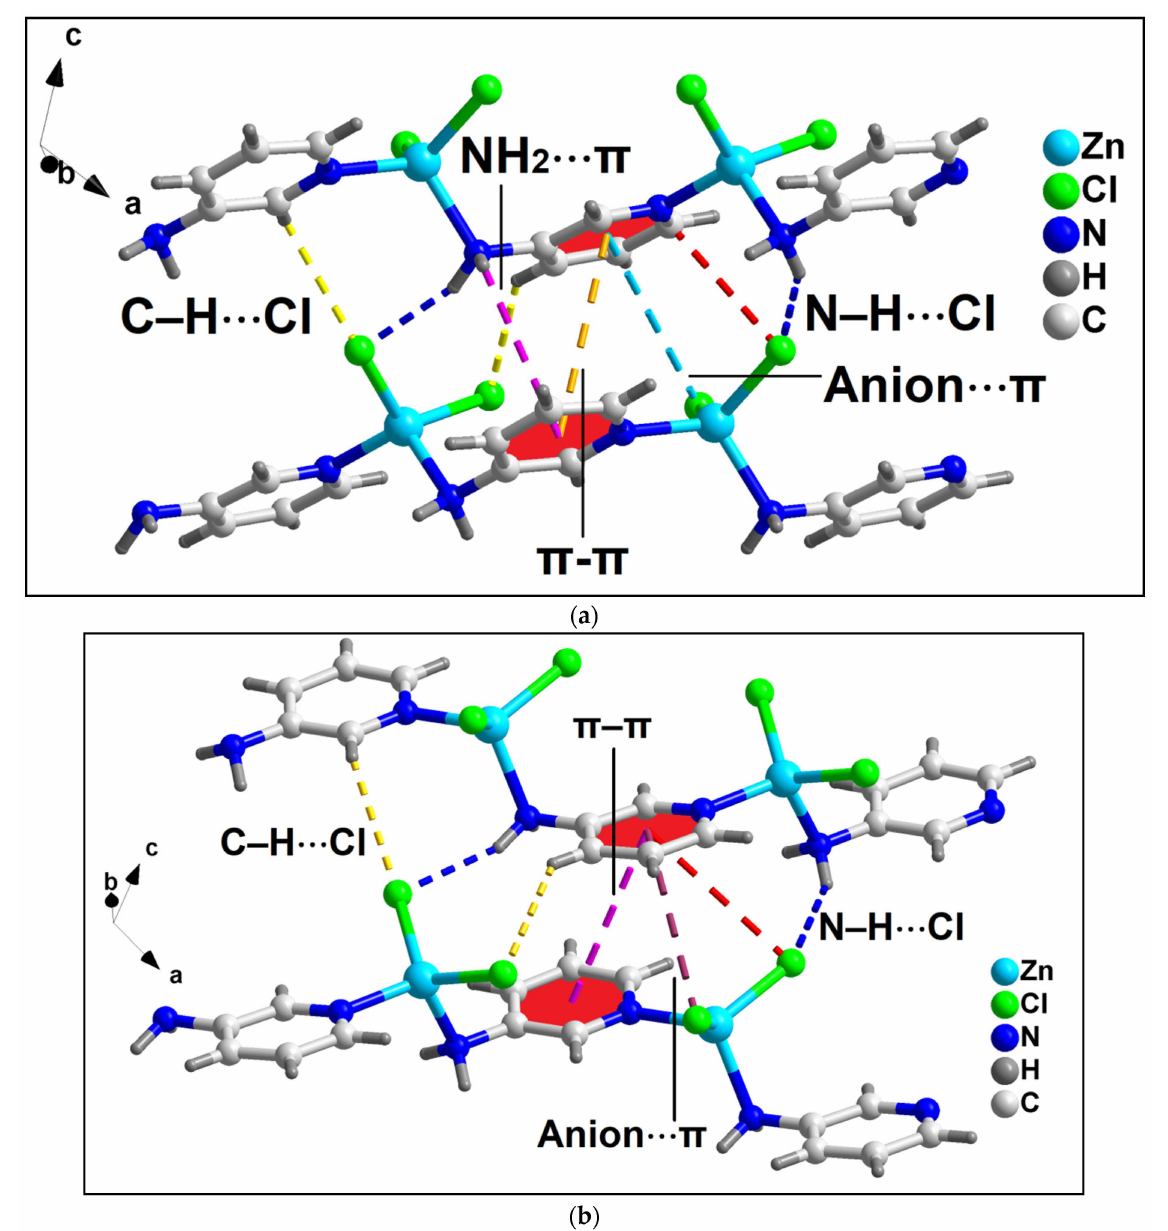
Figure 5. Two partial views ( a , b ) of the layered assembly of compound 2 along the crystallographic ac plane aided by anion · · · π , NH 2 ( amino ) · · · π , π – π , N–H · · · Cl, and C–H · · · Cl